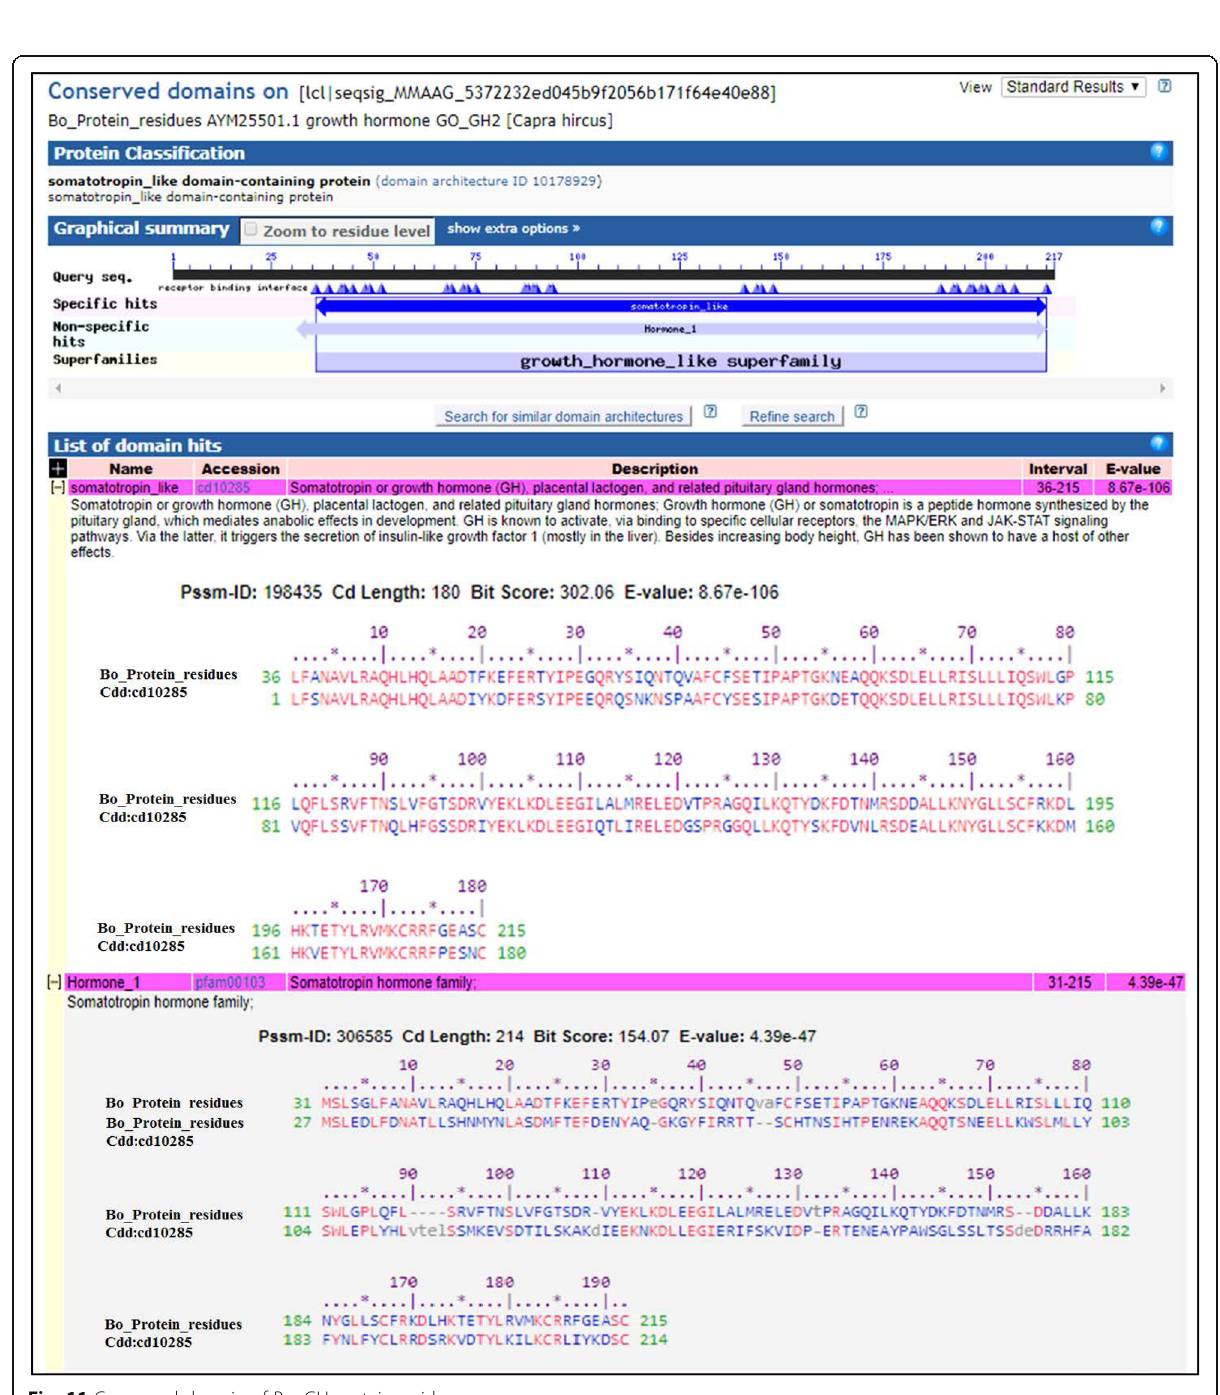
Fig. 11 Conserved domain of Bo_GH protein